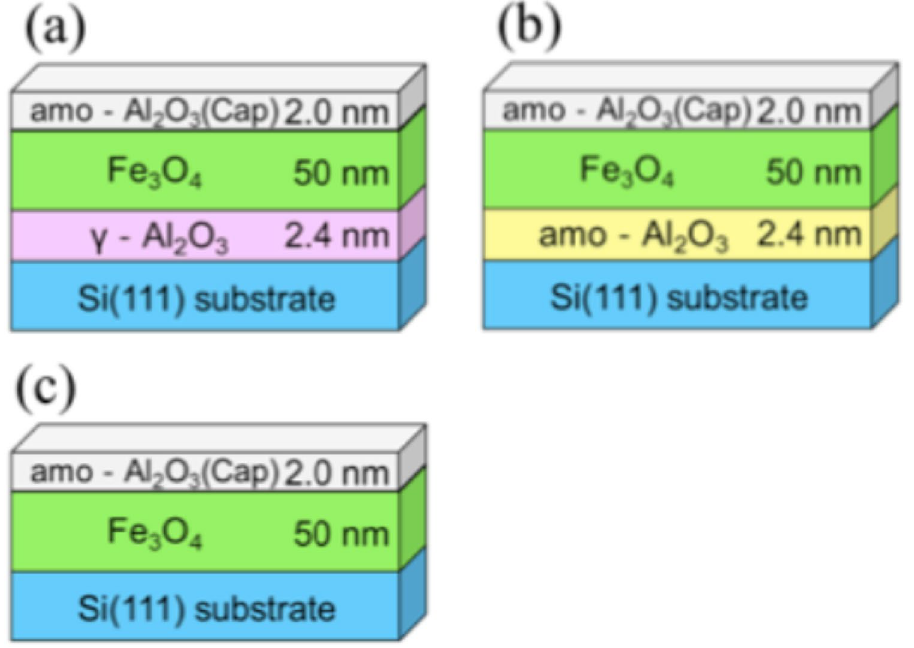
Figure 1. Sample structures: ( a ) the sample with γ -Al 2 O 3 buffer layer (EPI), ( b ) with amorphous-Al 2 O 3 buffer layer (AMO), and ( c ) without a buffer layer